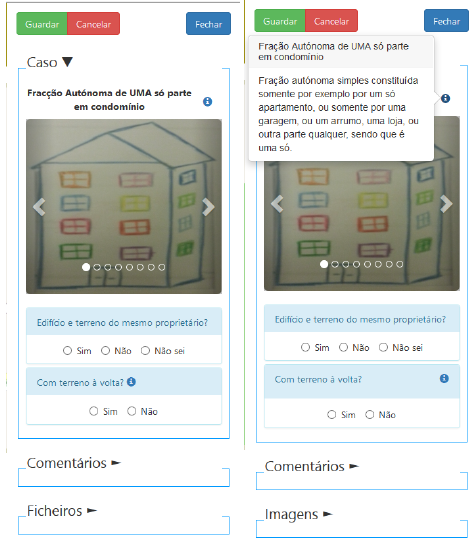
Figure 4: Two Tier Property Case Selection Using Questions (left) and providing Additional Information